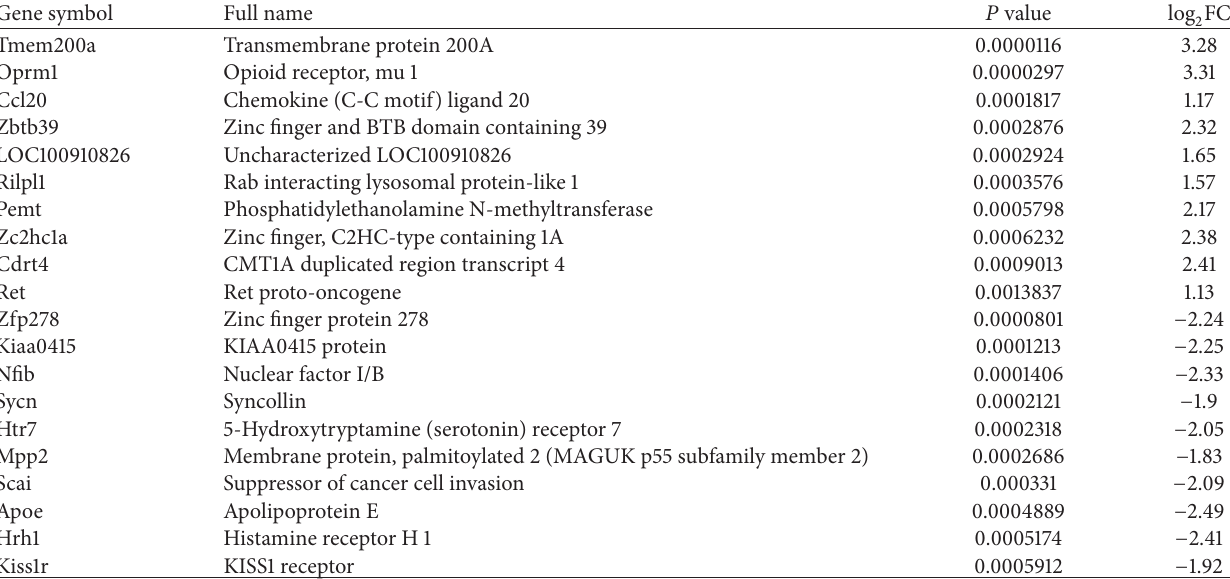
Table 1: The most significant upregulated and downregulated DEGs (top 10 of each) from earlier stage. Gene symbol